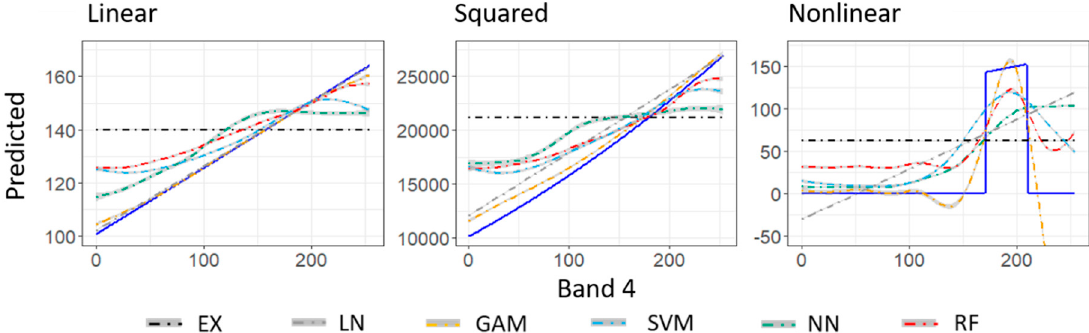
Figure 5. Depiction of functional relationships of fully-specified estimators and SC1 surface values (blue line) for a slice of predictor variable space where NAIP cell values were held constant at the mean for bands 1–3 while band 4 cell values ( x -axis) were allowed to vary. The amount of random noise introduced into the relationships between predictor and SC1 surfaces was 40% of the SC1 surface standard deviation. Sample design used to generate models was simple random sampling. Dashed colored lines correspond to averaged expansion and model-based estimates. The grey shaded regions around each estimation technique correspond to the 99% empirically based confidence interval given the 100 iterations performed. Sample size for expansion estimates and model calibration was 50. EX = expansion; LN = linear; GAM = general additive model; SVM = support vector machine; NN = neural networks; RF = random forests.